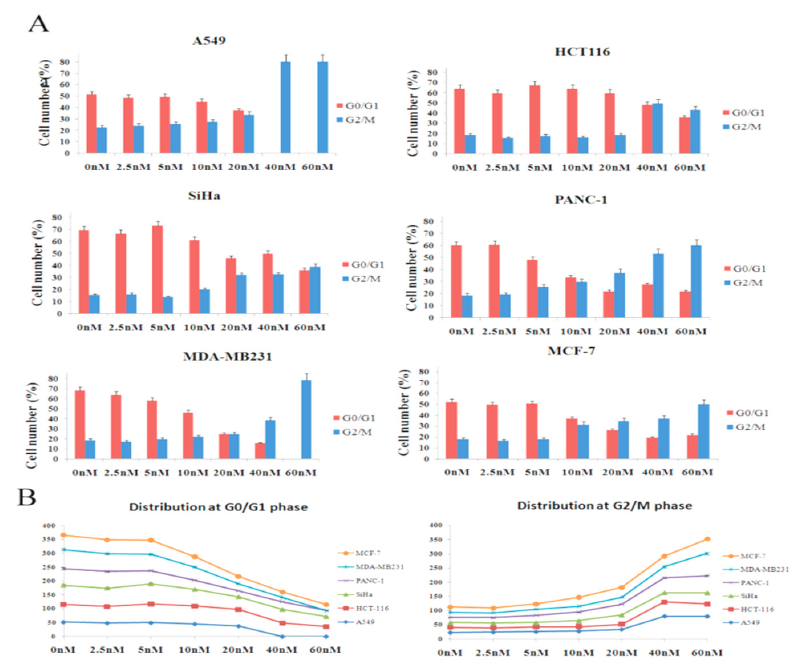
Figure 7. Effect of colchicine on cell cycle distribution in six human cancer cell lines (A549, HCT116, SiHa, PANC-1, MDA-MB231, and MCF-7). ( A ) Cells treated with different doses of colchicine (2.5–60 nM) for 24 h were stained with Propidium Iodide (PI) and analyzed using flow cytometry, based on 8000 cell counts. ( B ) Dose-response curve showing the effect of colchicine at the G0/G1 and G2/M phase, using doses ranging from 0 to 60 nM, using six human cancer cell lines.